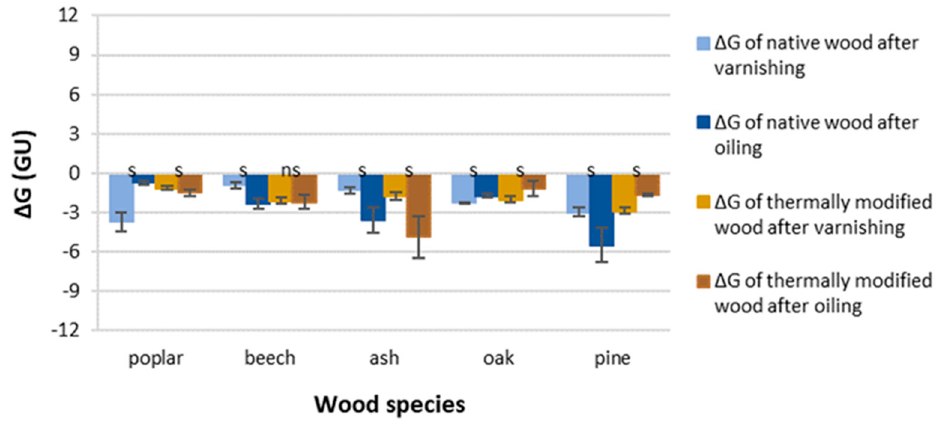
Figure 9. The gloss changes ∆ G of varnished, oiled native and thermally modified wood after photoaging (s—significant differences, ns—no significant differences between native wood after oiling and varnishing, or between thermally modified wood after oiling and varnishing, based on the t − test, p ≤ 0.05).